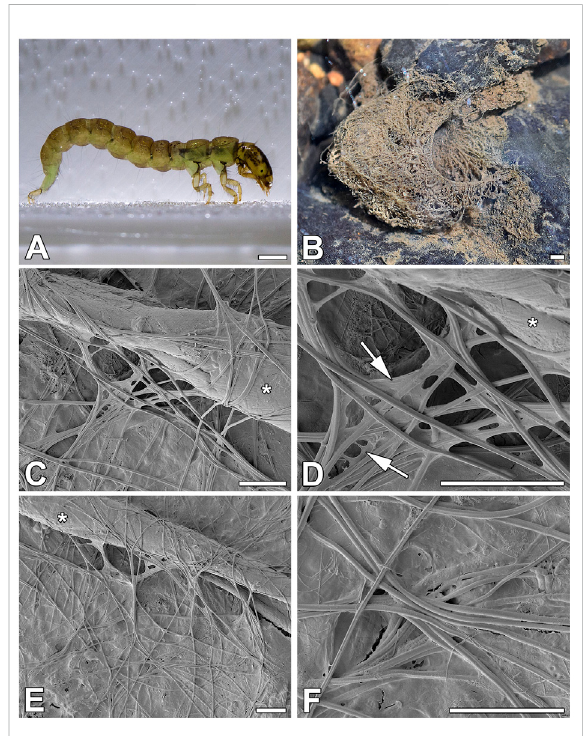
FIGURE 1 Silk of P. conspersa . (A) P. conspersa larvae; (B) P. conspersa silken net in the natural environment; (C – F) Scanning electron microscopy (SEM) of the silk fi bers spun by the larvae in laboratory conditions caught on the surface of an aluminum holder at various magni fi cations. It is clearly distinguishable that the fi bers arecomposedoftwo fi laments,andtheyareslightly fl attened.The arrows indicate the mass of adhesive material that stretches between the fi bers. Asterisks mark a piece of plant debris that the fi bres attached to. Scale-bars: (A,B) 1 mm; (C – F) 10 μ m.